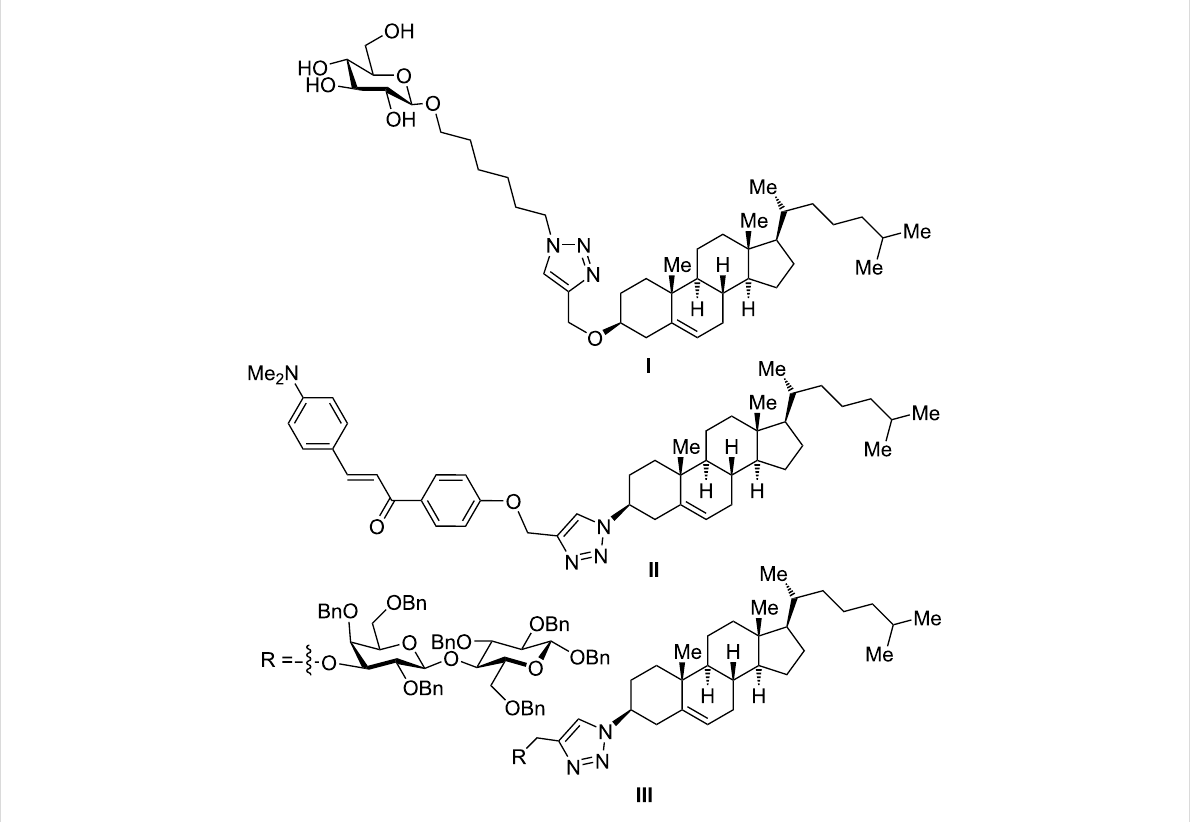
Figure 2: Selected previously described cholesterol derivatives with interesting antibacterial and cytotoxic activities [9,10]. The current results correct the structure of cholesterols II and III to be in the α - and not, as reported before and shown in this Figure, in the β -configuration.